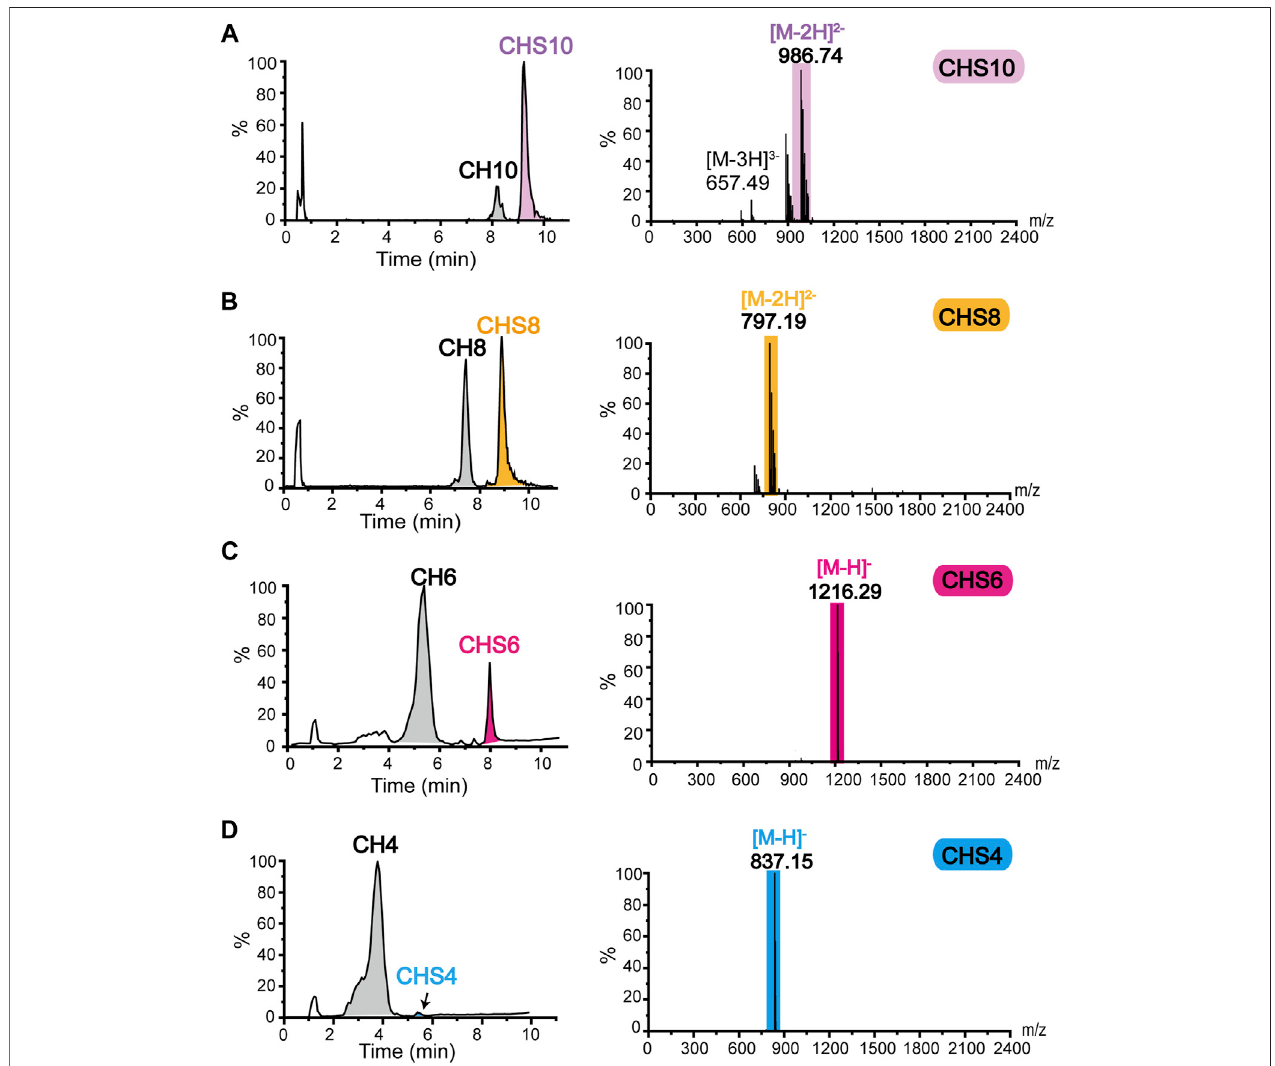
FIGURE 6 | Mass spectrometry identi fi cation of sulfate derivatives of chondroitin oligosaccharides (A) Mass spectrometric identi fi cation of CH10 sulfated to CHS10. (B) Mass spectrometric identi fi cation of CH8 sulfated to CHS8. (C) Mass spectrometric identi fi cation of CH6 sulfated to CHS6. (D) Mass spectrometric identi fi cation of CH4 sulfated to CHS4. CHS2, chondroitin disaccharide sulfate derivative; CHS4, chondroitin tetrasaccharide sulfate derivative; CHS6, chondroitin hexasaccharide sulfate derivative; CHS8, chondroitin octasaccharide sulfate derivative; CHS10, chondroitin decasaccharide sulfate derivative.